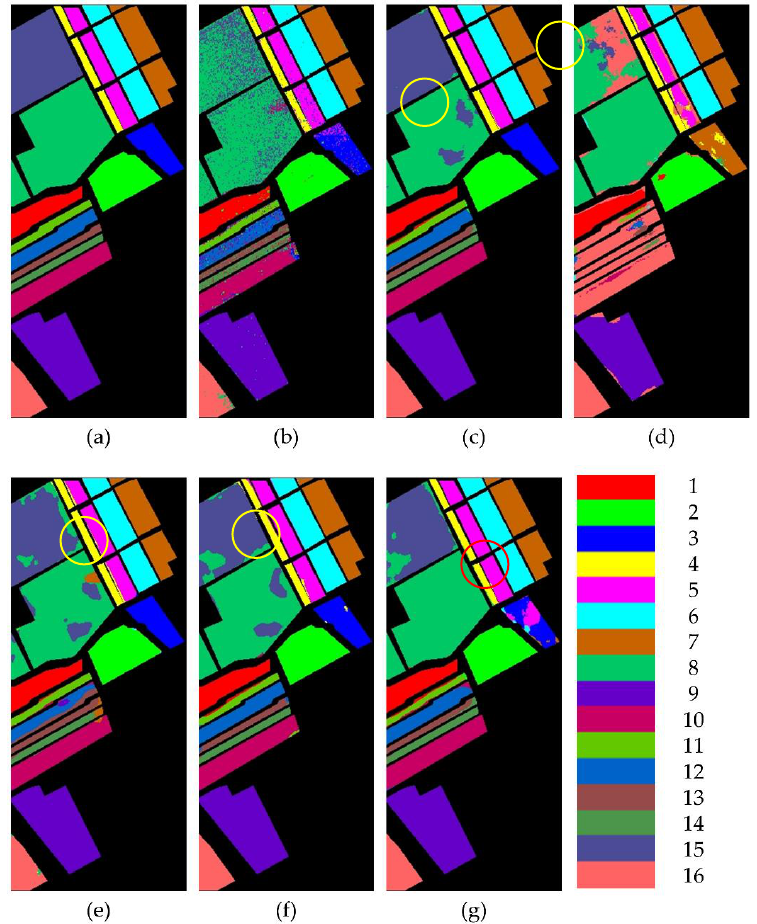
Figure 4. Ground truth and classification results of the SA dataset: ( a ) ground truth; ( b ) SVM; ( c ) 2D CNN; ( d ) 3D CNN; ( e ) 3D – 2D – 1D CNN; ( f ) 3D – 2D – CBAM – 1D CNN; ( g ) MDAN (3D – 2D – CBSM – 1D CNN). This figure shows the classes with lower classification accuracy in the yellow circle and the red circle.